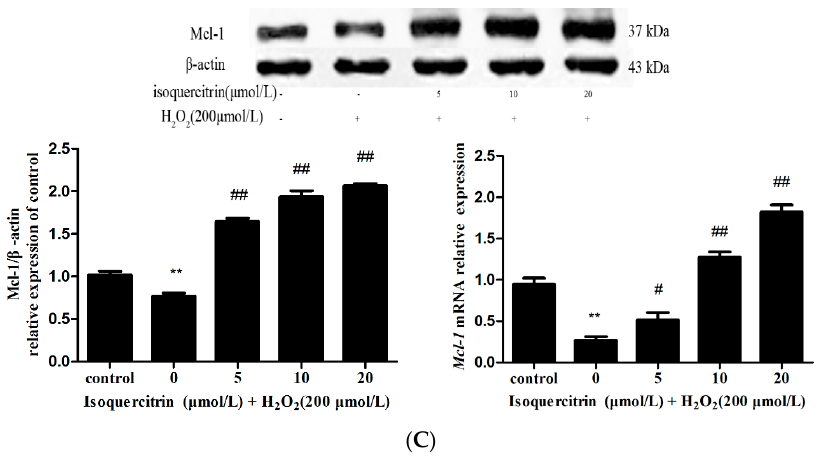
Figure 4. Effects of isoquercitrin on mitochondrial membrane potential and expression of cleaved caspase-3,-9 and Mcl-1 in H 2 O 2 -induced EA.hy926 cells.( A ) Effects of isoquercitrin on mitochondrial membrane potential in H 2 O 2 -induced EA.hy926 cells; ( B ) Effects of isoquercitrin on the expression of cleaved caspase-3, cleaved caspase-9 in H 2 O 2 -induced EA.hy926 cells; ( C ) Effects of isoquercitrin on the expression of Mcl-1 in H 2 O 2 -induced EA.hy926 cells. * p < 0.05, ** p < 0.01 vs. the control; # p < 0.05, ## p < 0.01 vs. the H 2 O 2 -treated group.